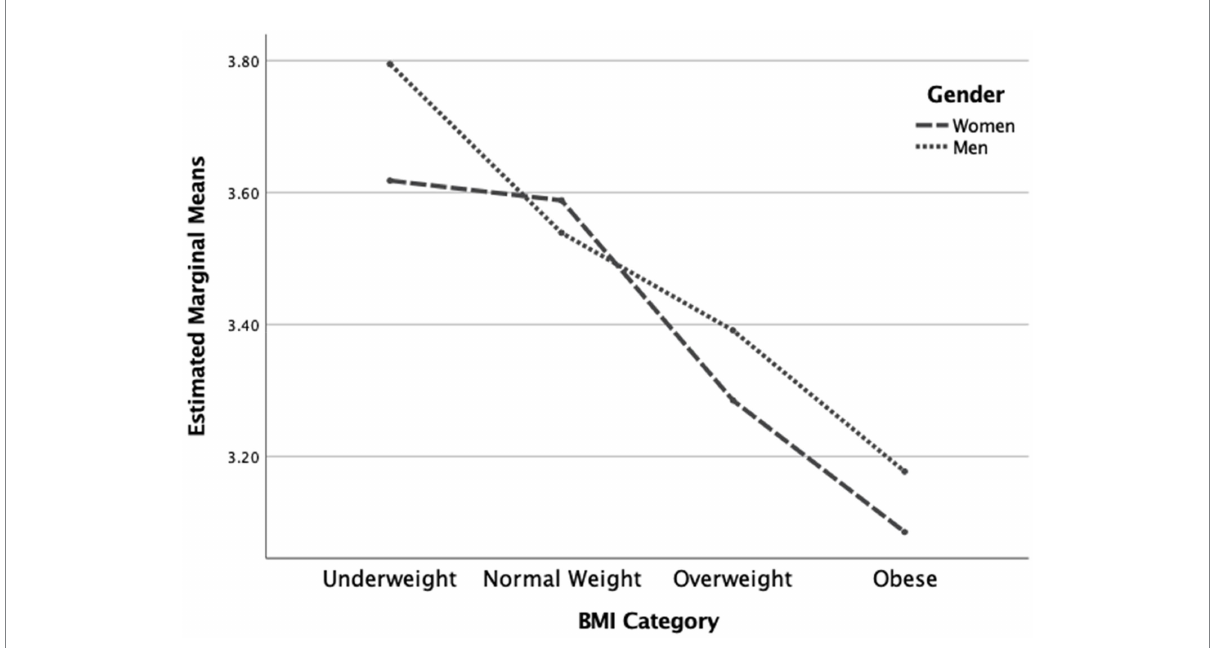
FIGURE 4 Interaction effect for reliance on hunger and satiety cues. N = 1,312 ( n = 657 for women, and n = 655 for men), p < 0.001.